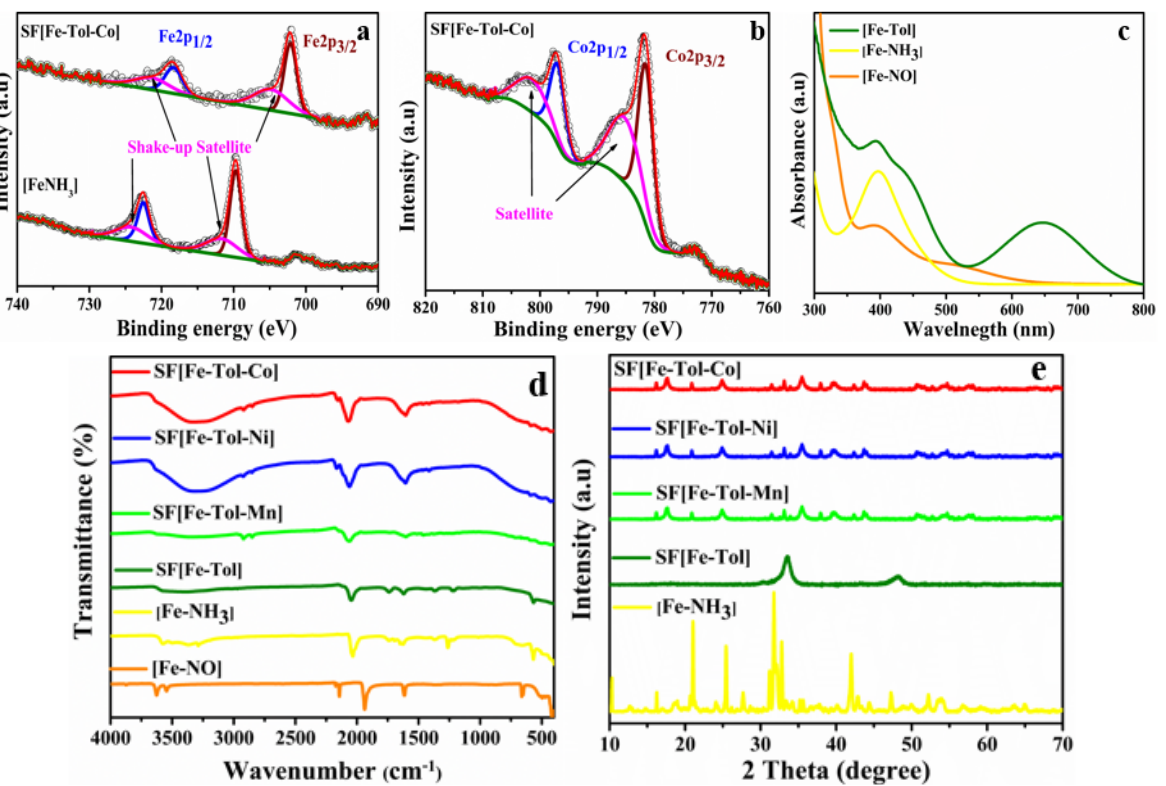
Figure 1. ( a ) XPS spectra of [Fe-NH 3 ] and SF[Fe-Tol-Co] for Fe, ( b ) XPS spectrum of SF[Fe-Tol-Co] for Co, ( c ) overlaid UV-visible spectra of [Fe-NO], [Fe-NH 3 ] and [Fe-Tol], ( d ) overlaid FT-IR spectra of [Fe-NO], [Fe-NH 3 ], [Fe-Tol] and SF[Fe-Tol-M] and ( e ) XRD patterns for [Fe-NH 3 ], [Fe-Tol] and SF[Fe-Tol-M] (where M = Mn, Co, Ni).